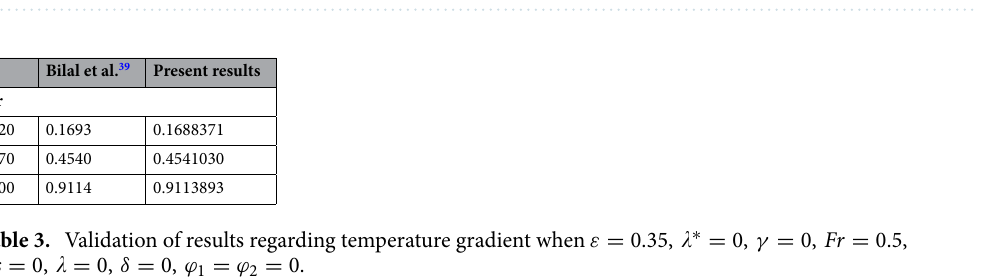
Figure 8. Temperature curves against (cid:31) ∗ when ε δ = 0.53, ϕ 1 = 0.003, ϕ 1 = 0.075.